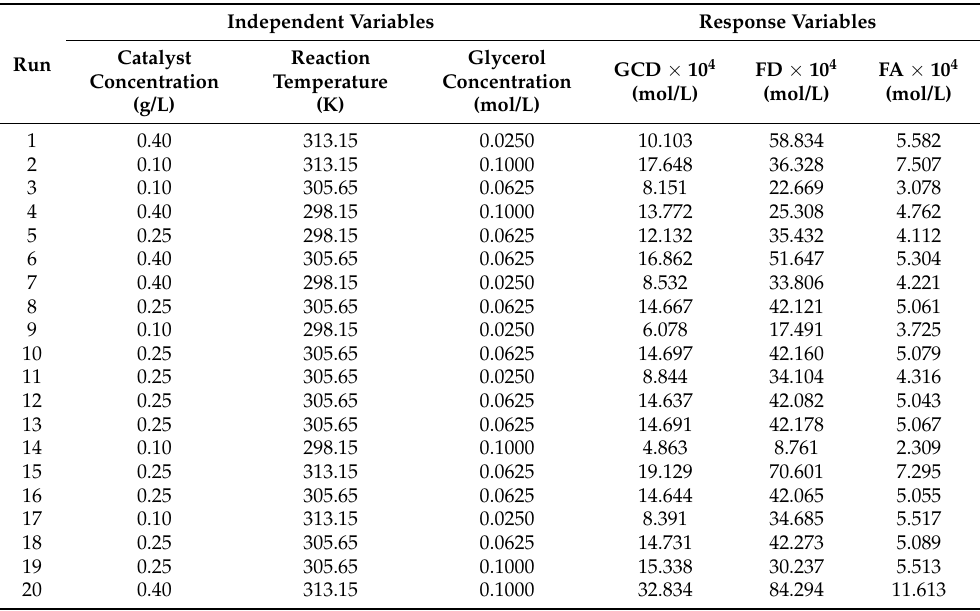
Table 4. Experimental design with independent variables and response variables for the selective photo-oxidation of